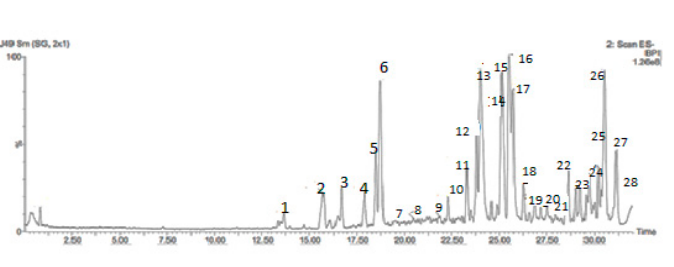
Figure 2. SEM ( A) and TEM ( B ) micrographs of round state of Ag-nanoparticles of mustard with a size range from 4.8 to 39.5 nm.